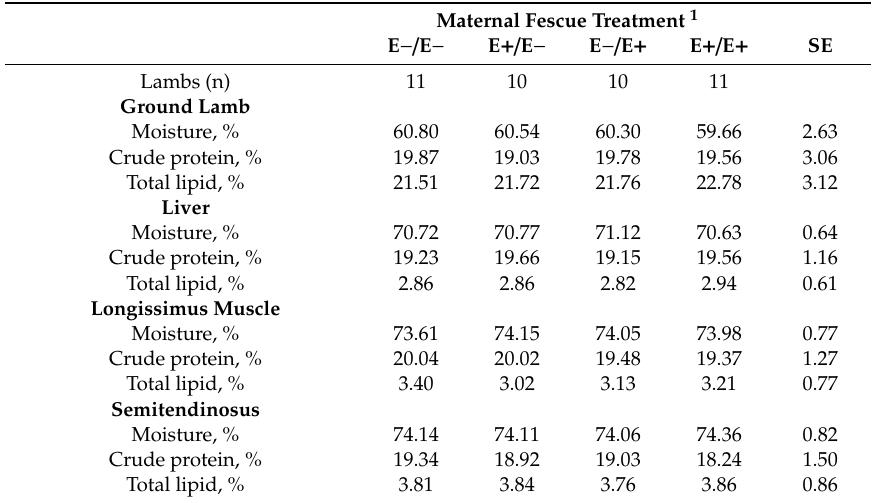
Table 5. Proximate and fatty acid composition of tissues from wethers born to ewes consuming endophyte-infected (E + ) or endophyte-free (E − ) fescue during MID (d 35-85) and LATE (d 86- parturition) gestation.